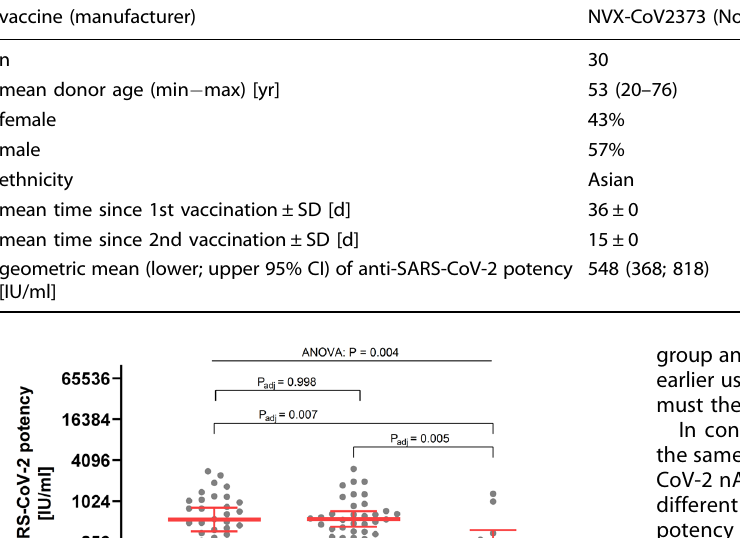
Table 1. Demographic characteristics of study groups and summary data of serum SARS-CoV-2 neutralizing antibody levels. vaccine (manufacturer)